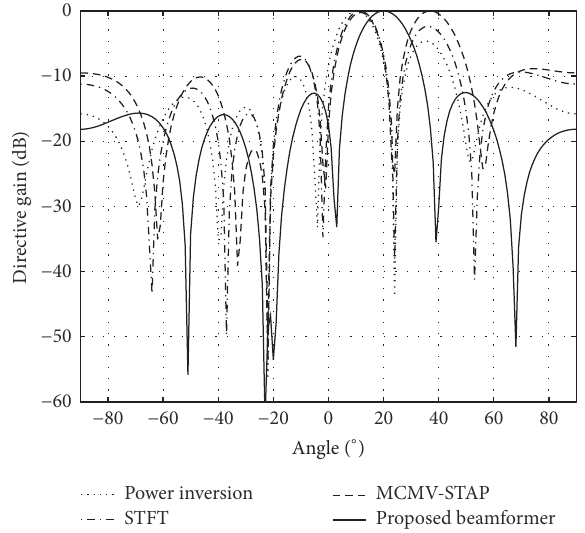
Figure 12: The array antenna pattern of antijamming for different method: the angle of arrival of the satellite signal is 20 degrees and the angles of arrival of jamming signals are 24 degrees and − 22 degrees.